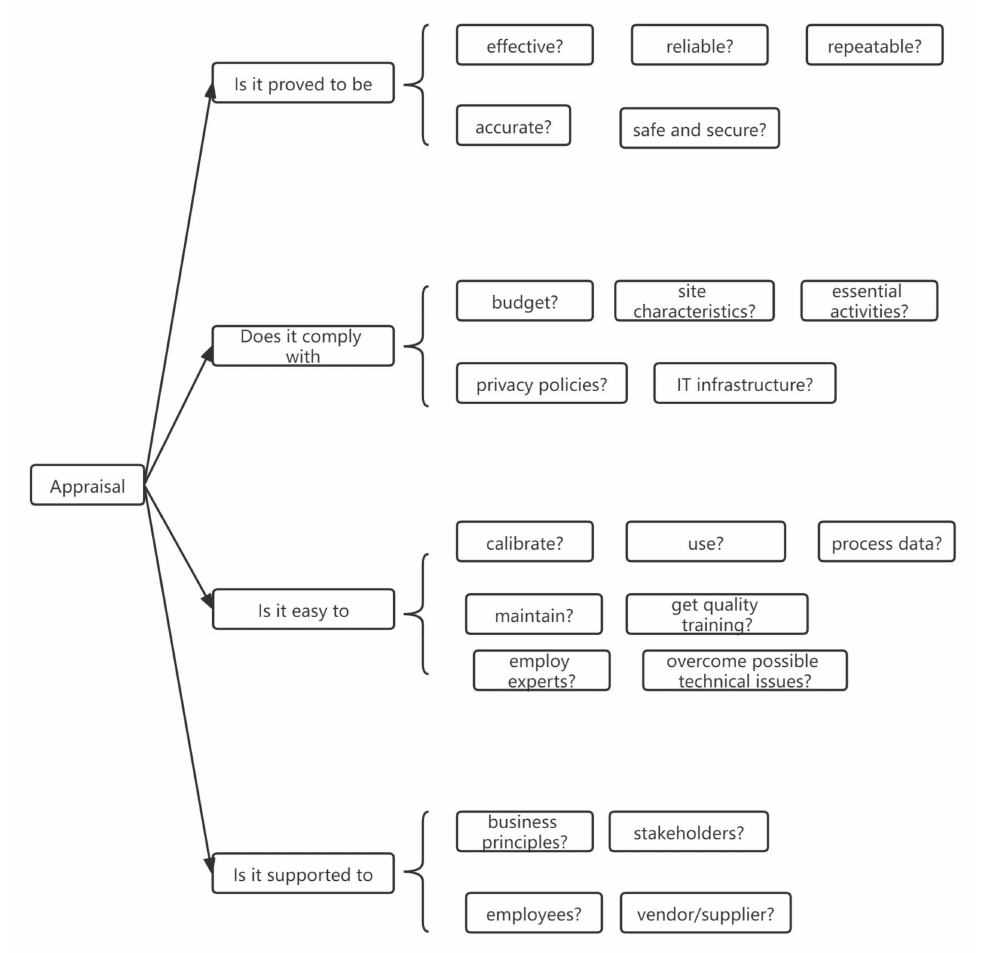
Figure 16. Appraisal